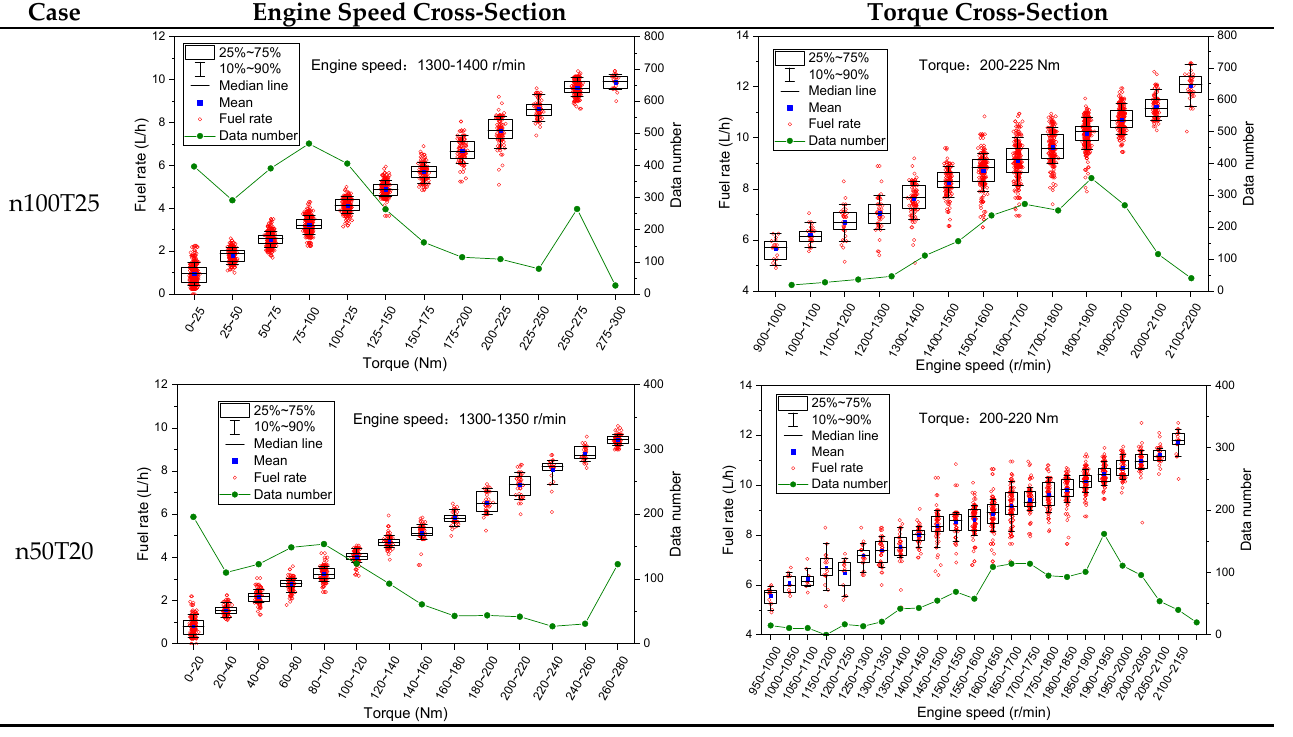
Figure 4. Clustering of the fuel rate bins (vehicle 1). After obtaining the average fuel consumption rate for each bin, the chassis dynamometer test process can be reproduced, or “reconstructed”, by matching the torque bin number 𝑎 and the engine speed bin number 𝑏 second by second, as presented in Figure 5. It is noteworthy that the predicted or “reconstructed” fuel rate curve yields good agreement with the experimental results. The relative errors between the predicted accumulated fuel consumption over the driving cycle and measurements are 1.42% and 1.70% for n100T25 and n50T20, respectively, validating the feasibility of the proposed binning-reconstruction model. Exp. Cal.